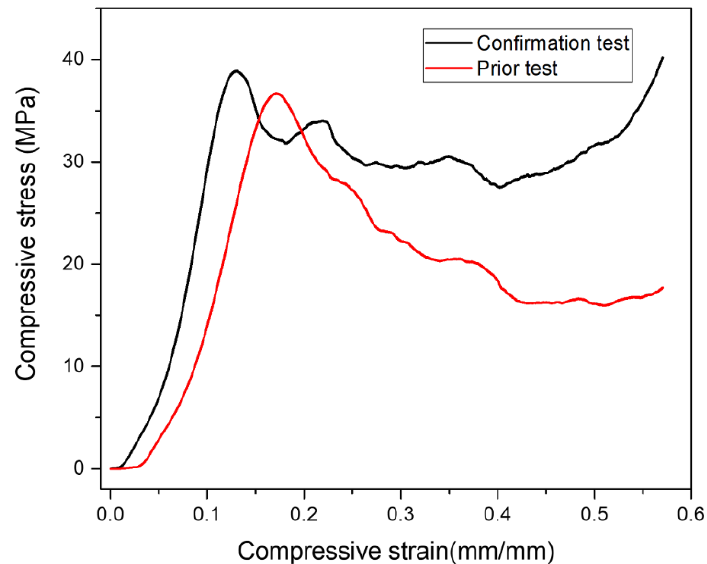
Figure 17. Comparison of confirmation test result at optimal input factors and maximum value obtained from Taguchi L9 runs.